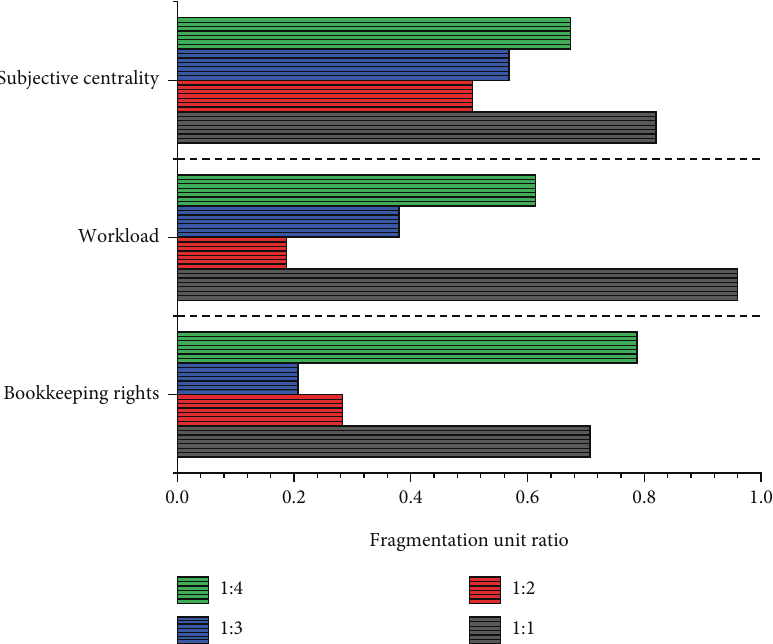
Figure 3: Variation characteristics of central factor and discrete characteristics of open consensus